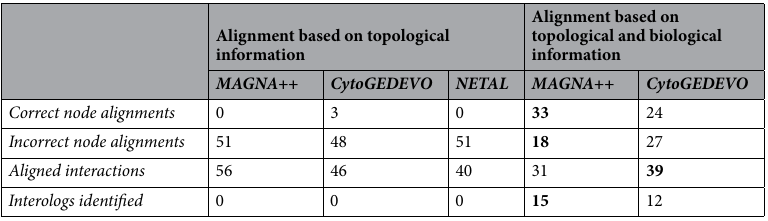
Table 1. GNA algorithm evaluation results. Three GNA algorithms were evaluated based on their ability to correctly align predicted ortholog proteins (51) and identify interologs (22). Bold is used to indicate the best value for each metric. All algorithms failed to align the networks using topological information exclusively and combination with biological information proved necessary for the correct alignment of protein